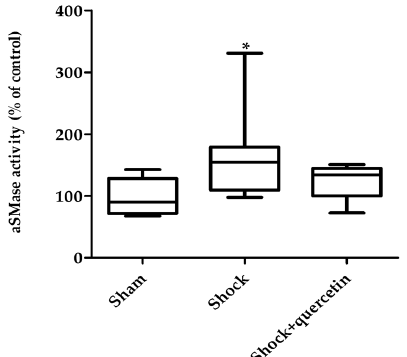
Figure 3. aSMase activity. Measurements were made in lung homogenate for a total time of 30 min expressed as nmol/min/mL. * p < 0.05 vs. sham group. Box-and-whisker plot showing medians with interquartile range and minimum and maximum